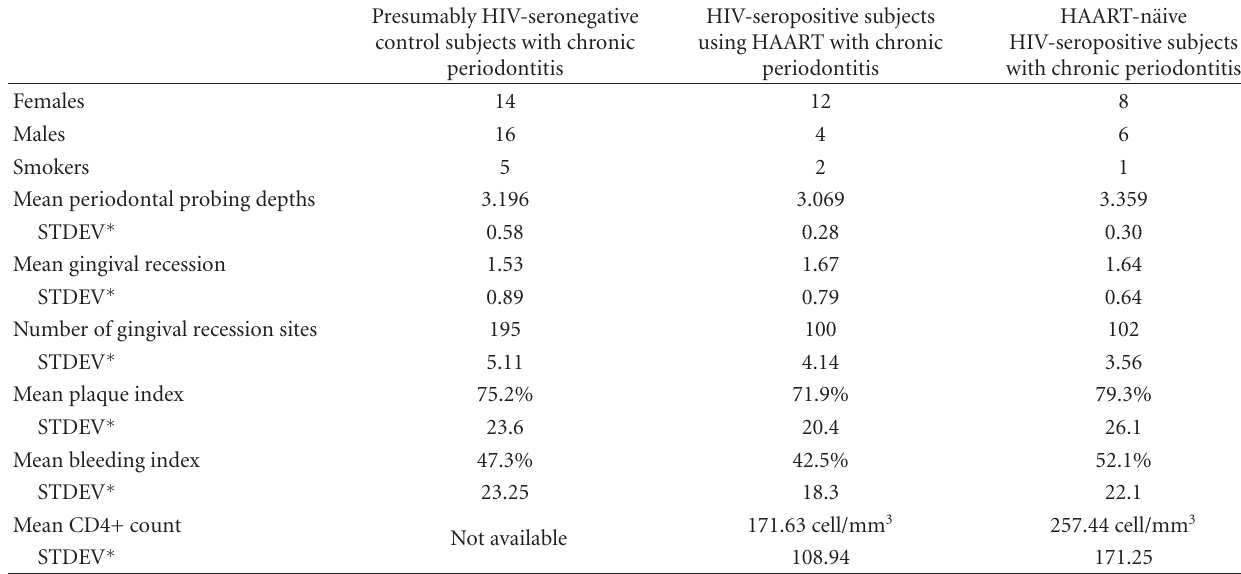
Table 2: Epidemiological features, periodontal indexes, and immunological indexes of HIV-seropositive subjects using HAART of HAART- na¨ıve HIV-seropositive subjects and of control subjects. All subjects had chronic periodontitis.